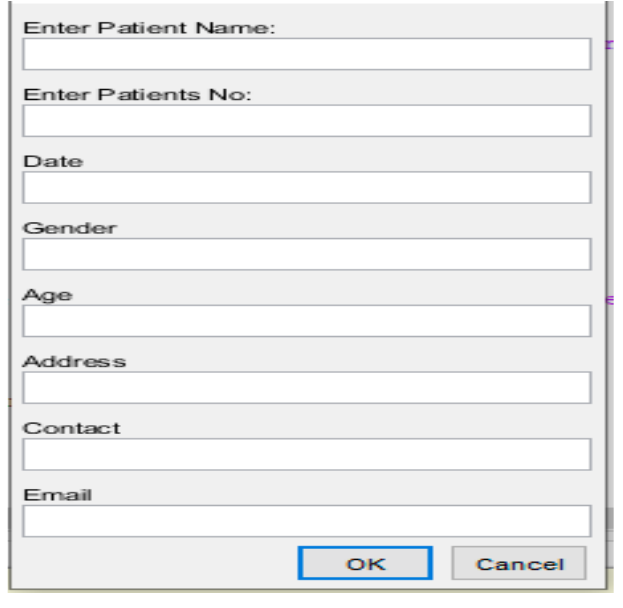
Figure 7. Registration details.